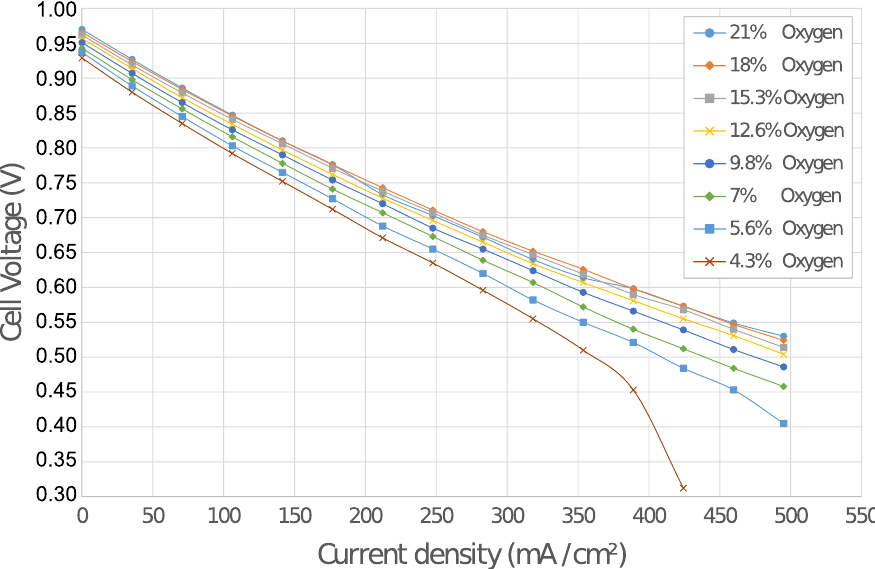
Figure 12. The performance of the cell at 850 ◦ C with decreasing oxygen partial pressure. The performance decreases for lower partial pressures, under 12.6% oxygen. However, the loss is less than that at 800 ◦ C.